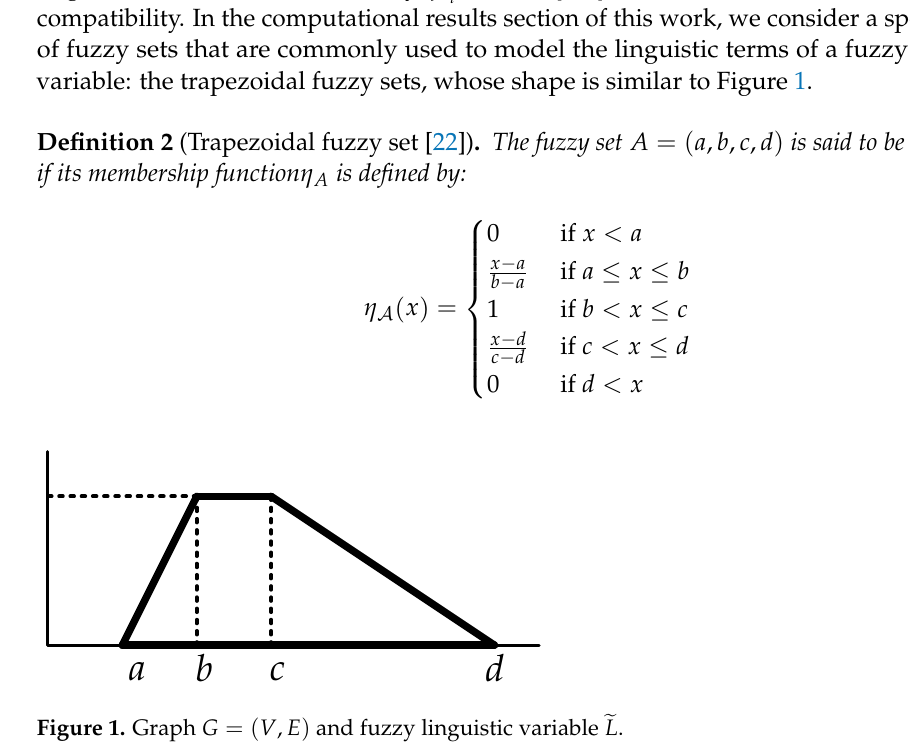
Figure 1. Membership function of a trapezoidal fuzzy set.